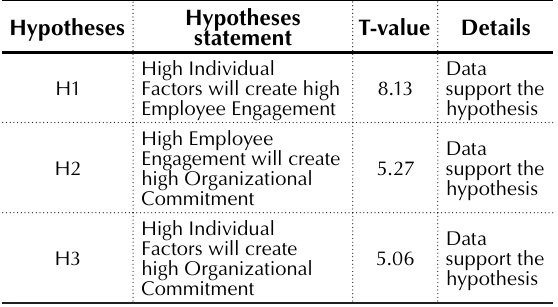
Table 1. Hypotheses testing